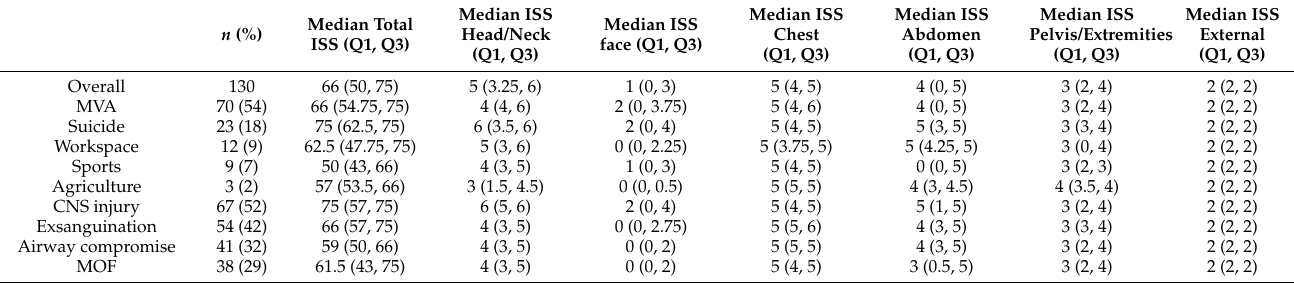
Table 2. Median (Q1, Q3) total ISS and severity in respective ISS body regions according to trauma mechanisms and causes of